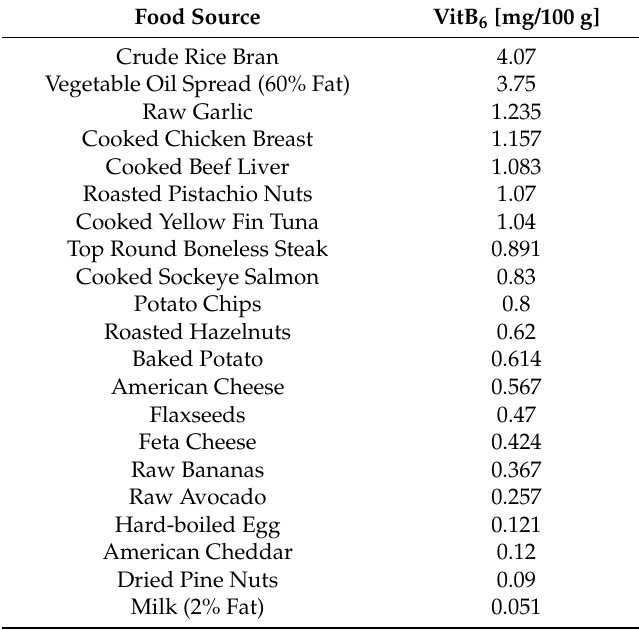
Table 1. Selected Foods and VitB 6 Content based on the USDA Food Composition Database (https: